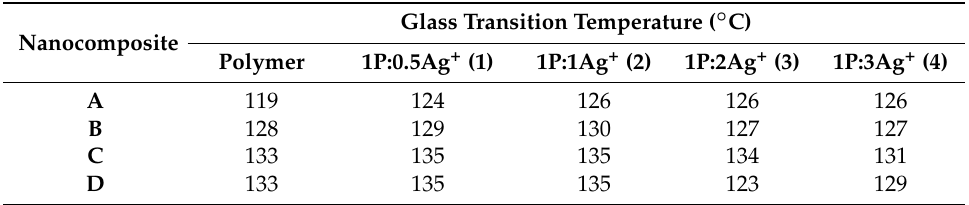
Figure 9. DSC curves of the polymer A and the resultant nanocomposites. Table 5. Glass transition temperatures of the different samples.